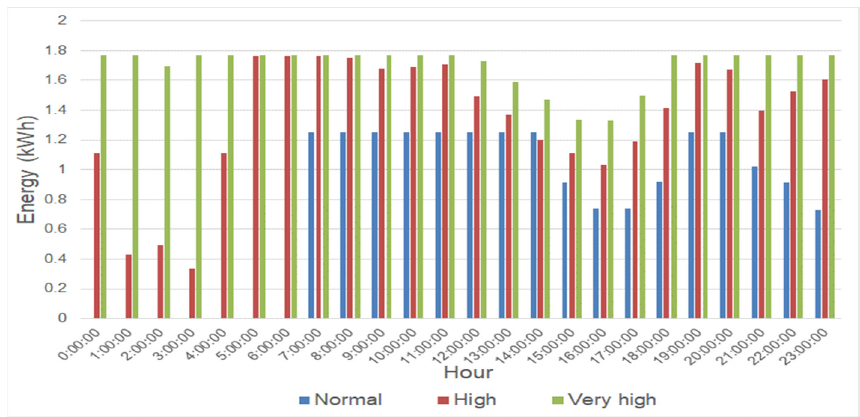
Figure 15. Average daily energy production for several consumption scenarios.